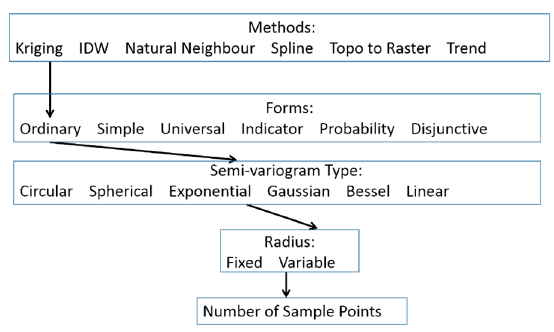
Figure 1. Interpolation decision tree.